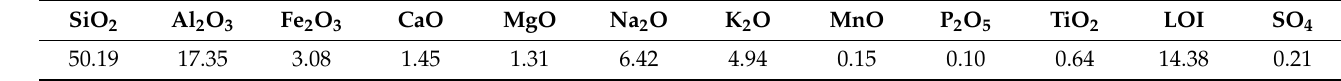
Table 4. XRF analysis of the tuff pozzolan.